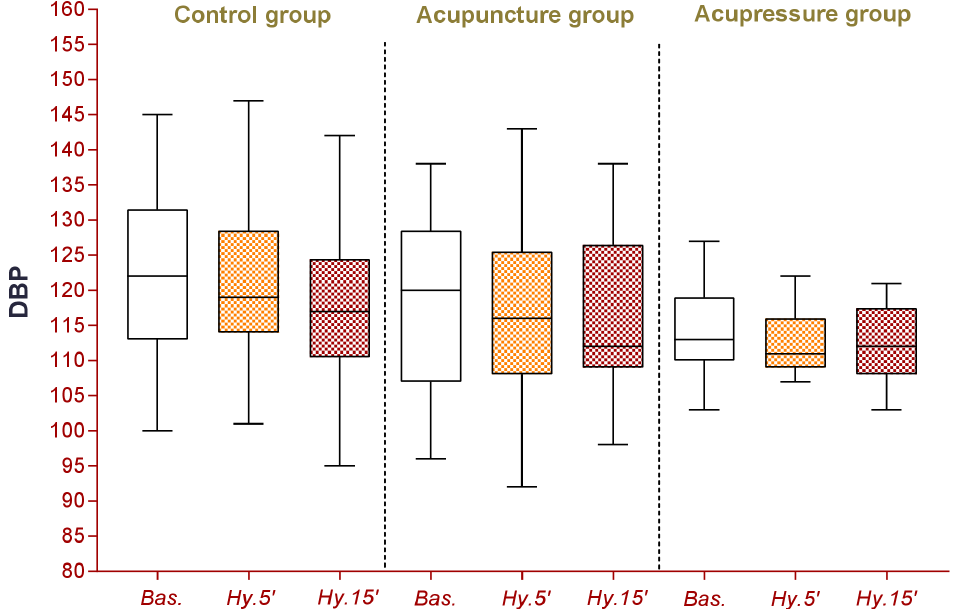
Figure 11. Descriptive analysis for millimeters of mercury of diastolic blood pressure (DBP) in control, acupuncture, and band (acupressure) groups at baseline and after 5 and 15 min of hypoxia.